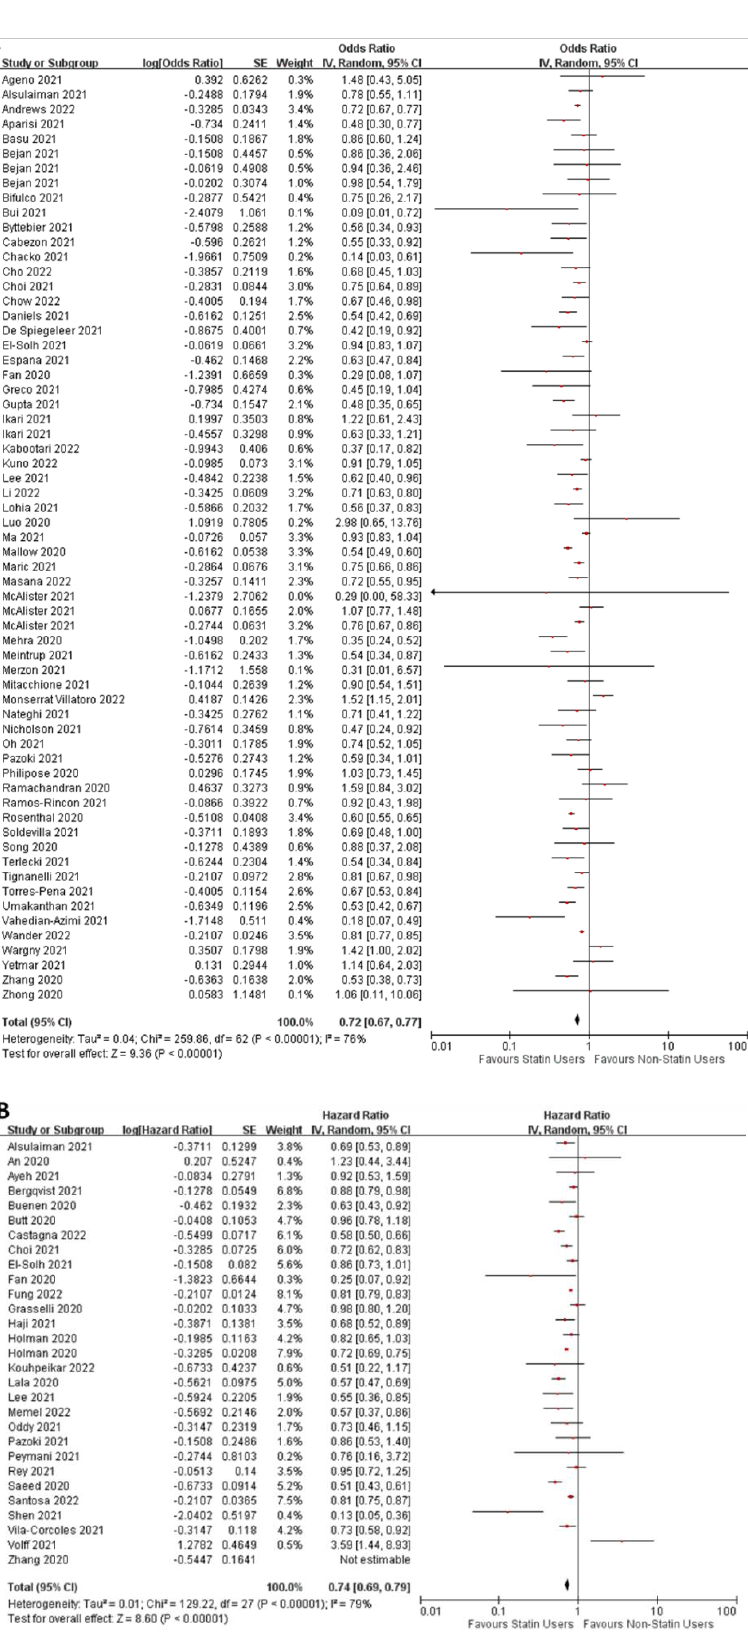
Figure 2. Forest plots of adjusted odds ratio ( A ) and hazard ratio ( B ) for mortality in statin users versus non-users among COVID-19 patients.